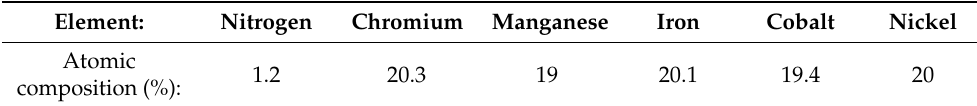
Figure 5. ( a ) Cross-sectional image of the as-built alloy. ( b ) corresponding EBSD map, with FCC matrix in red-pink color and σ phase precipitates in blue color. Table 1. Semiquantitative EDS chemical analysis (atomic %) of as-built alloy. Relative uncertainty on data is less than 2% except for N (30%) and Mn (7%).